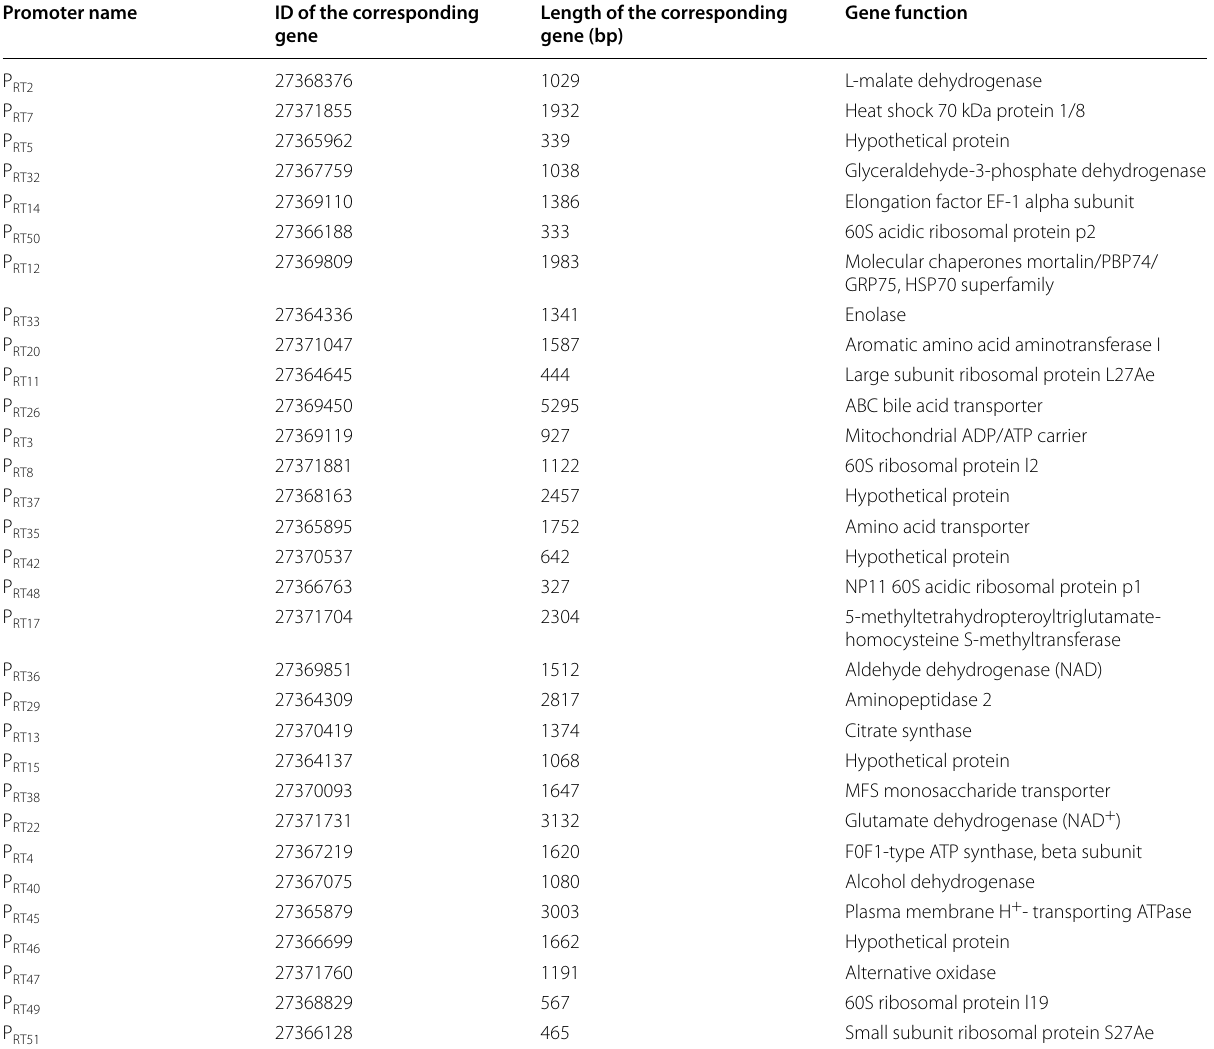
Table 1 Description of identified 31 promoters from R. toruloides .